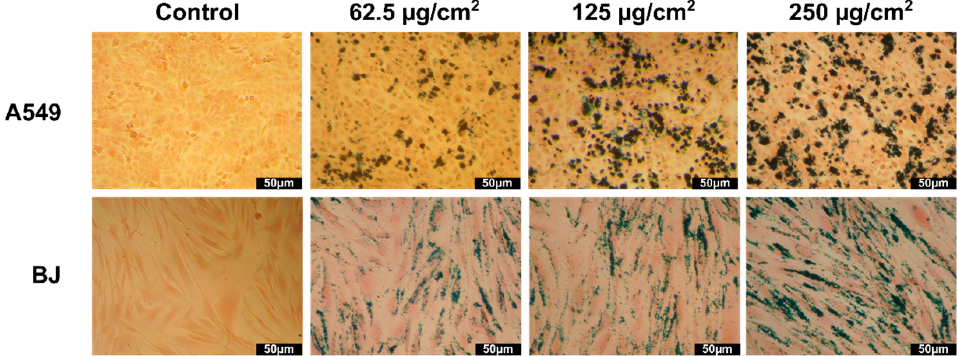
Figure 7. Microscopic images of A549 ( upper panels) and BJ ( lower panels) cells incubated with 62.5, 125, and 250 μ g/cm 2 ZnF01. Nanoparticles were stained with Prussian Blue.